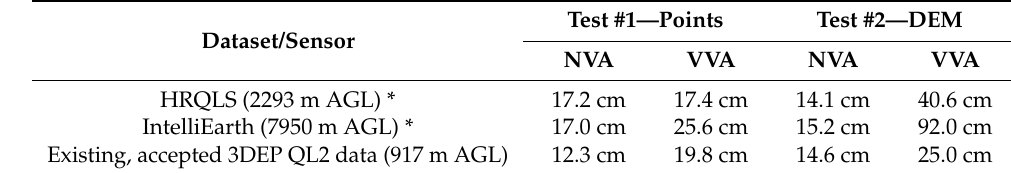
Table 4. Absolute accuracy tests using points and DEMs (* leaf on